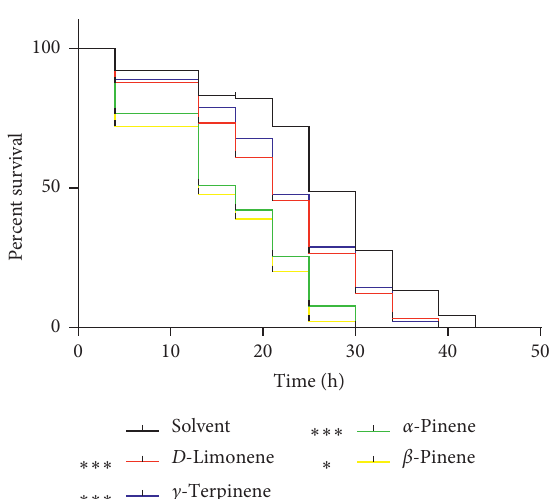
Figure 6: Four components in the flesh fingered citrons essential oil affect the oxidative stress resistance of wild-type C. elegans . At least three independent biological replications were performed, and the statistical significance of the differences between curves was demonstrated by a log-rank test using Kaplan − Meier survival analysis. Error bars represent the standard error, and differences compared to the solvent (0mg/ml, 0.1% DMSO) were considered significant at ∗ P < 0 . 05 , ∗∗ P < 0 . 01 , and ∗∗∗ P < 0 . 001 by one-way ANOVA and the LSD post hoc